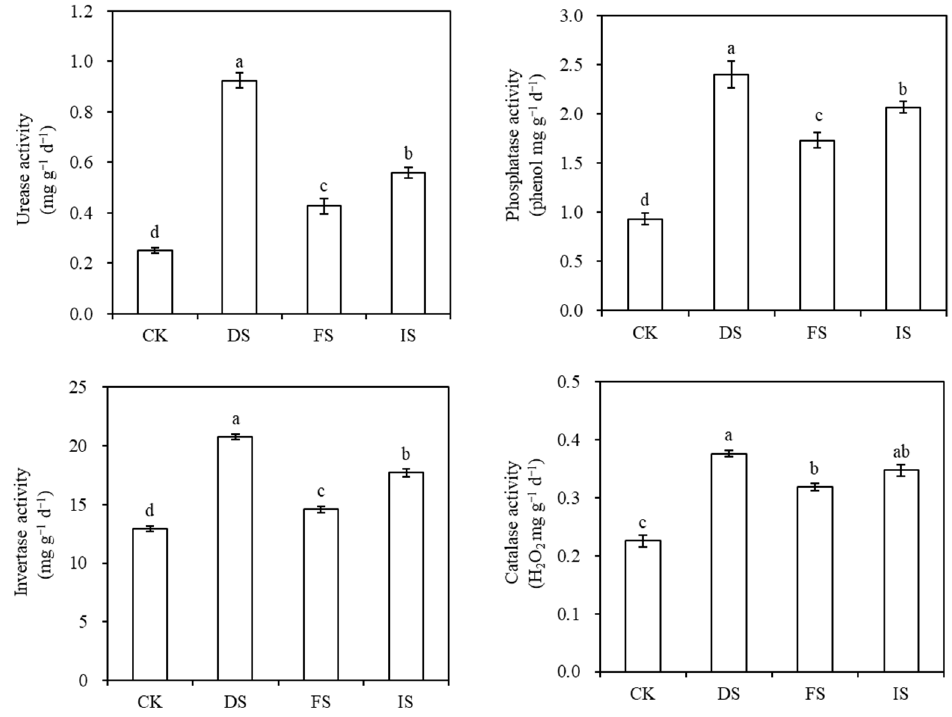
Figure 4. Effects of different forms of Tateges erecta biofumigation on the soil enzyme activity in replant soils. CK: replanted soil, DS: air-dried T . erecta sample, FS: fresh T . erecta sample, IS: infusion solution of fresh T . erecta . Data are the means of three replicates, and the different letters over on the columns indicate significant differences at p < 0.05.